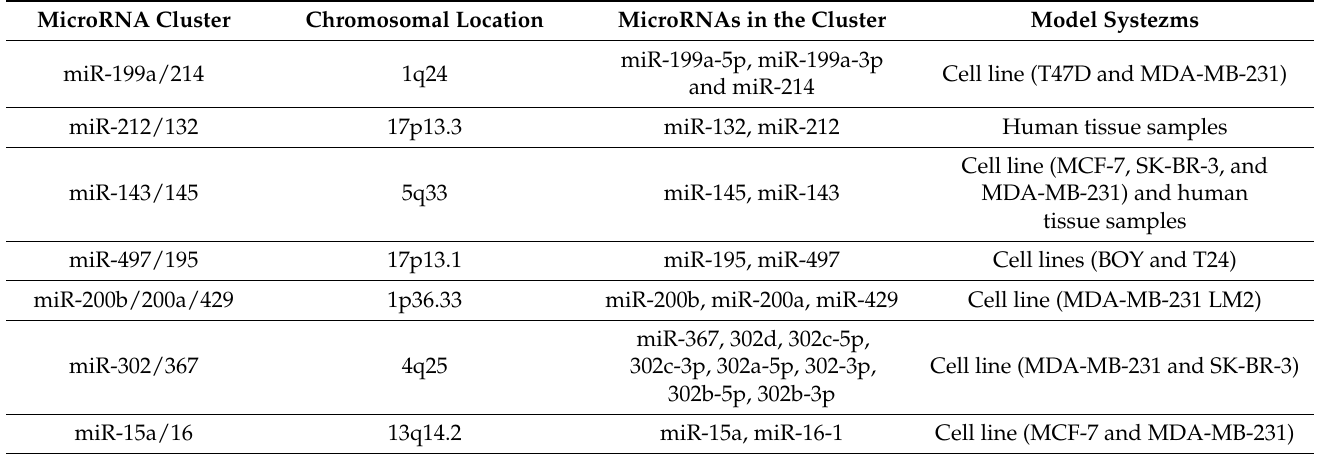
Table 2. Tumor suppressor MicroRNA Cluster, their Chromosomal location and members of Mi- croRNA